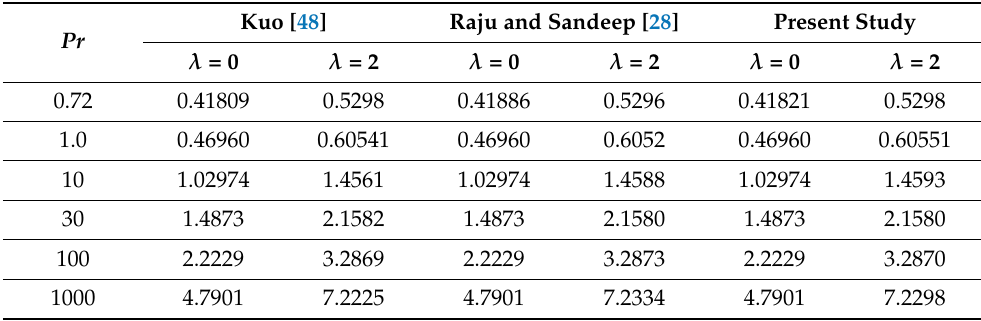
Table 1. Comparison of the local Nusselt number for different values of Pr when β → ∞ , N b = N t = Le = M = R = Pe = β 1 =